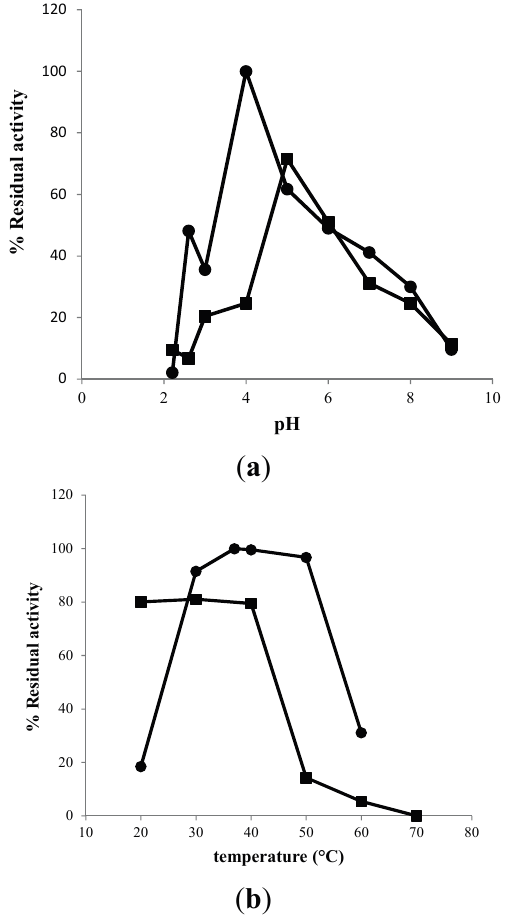
Figure 4. ( a ) Effects of pH on chitinolytic activity ( ● ) and stability ( ■ ) of EcChi1; ( b ) Effects of temperature on chitinolytic activity ( ● ) and stability ( ■ ) of